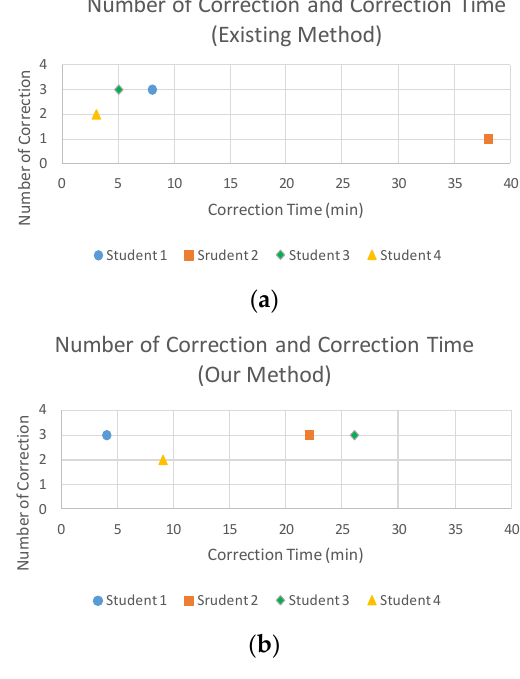
Figure 17. Scatter plots of ( a ) the existing method and ( b ) our method for the number of corrected defects and correction time.